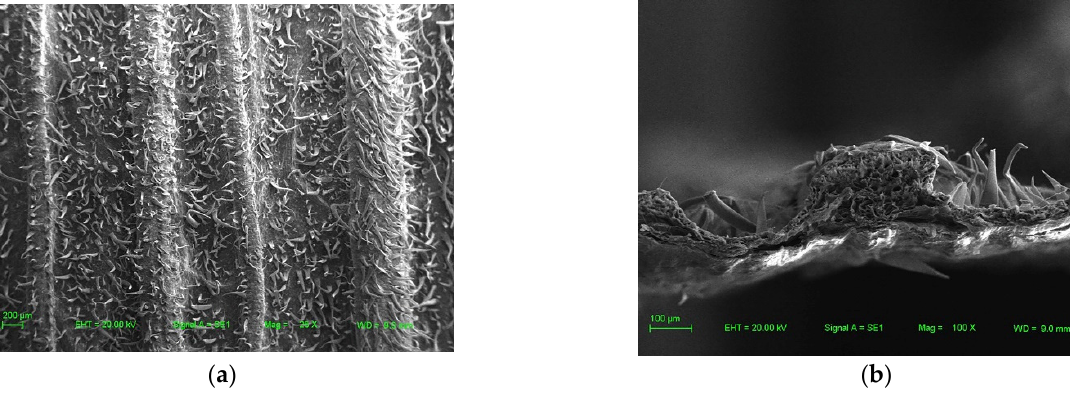
Figure 8. Surface and cross-sectional morphology of corn bracts: ( a ) surface morphology of corn bracts; ( b ) cross-sectional morphology of corn bracts. EHT = extra high tension, SE = secondary electron, Mag = magnification times, WD = work distance.